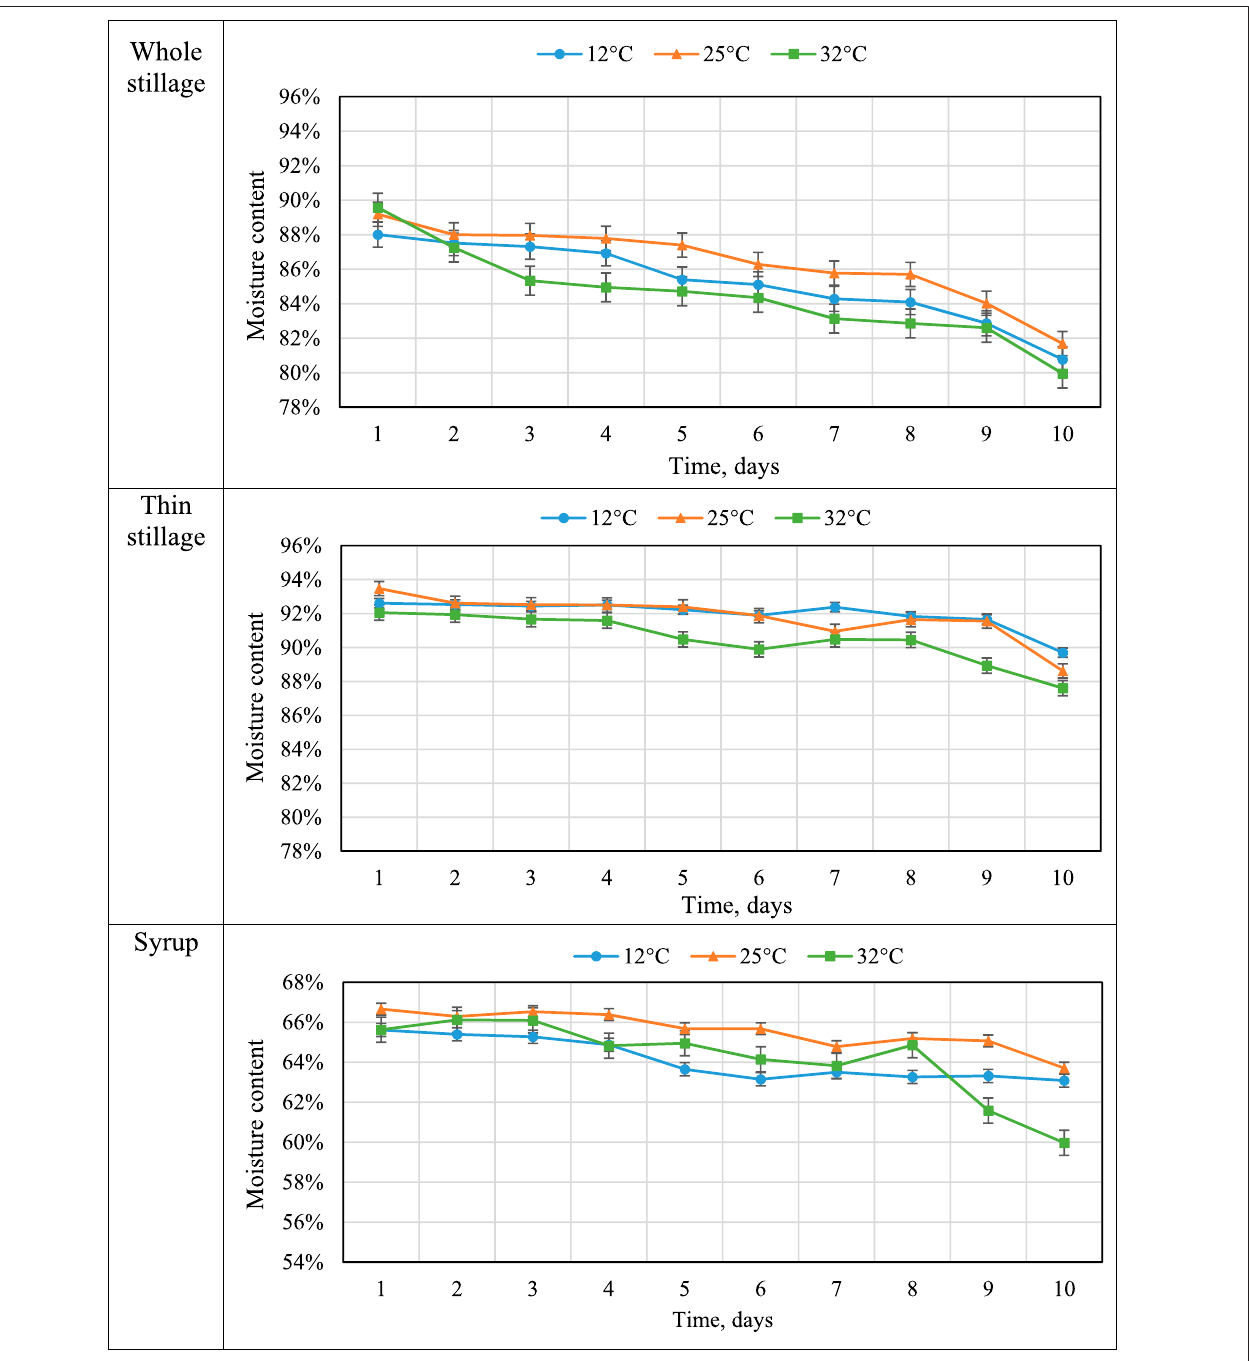
FIGURE 4 | Average moisture content changes over time. Error bars denote 1 standard deviation.